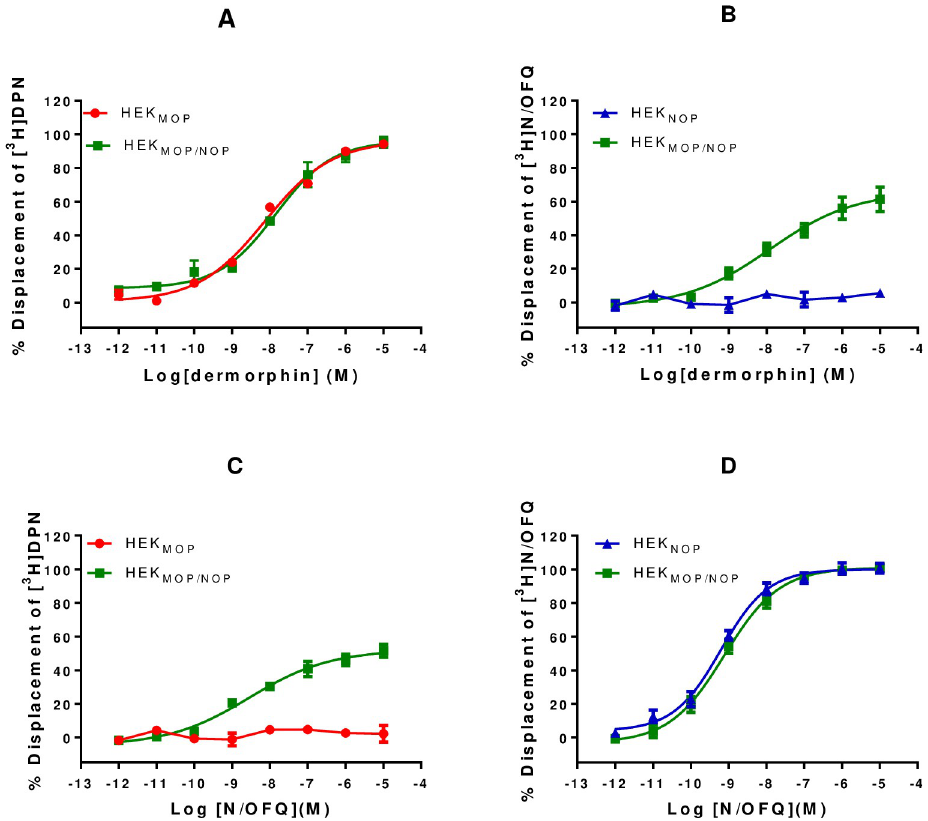
Fig 4. Displacement binding curves of A) Dermorphin in HEK MOP and HEK MOP/NOP cell membranes against [ 3 H]- DPN or B) in HEK NOP and HEK MOP/NOP cell membranes against [ 3 H]-N/OFQ. Displacement binding curves of C) N/ OFQ in HEK MOP and HEK MOP/NOP cell membranes against [ 3 H]-DPN or D) in HEK NOP and HEK MOP/NOP cell membranes against [ 3 H]-N/OFQ. Data are the mean ( ± SEM) of n = 5